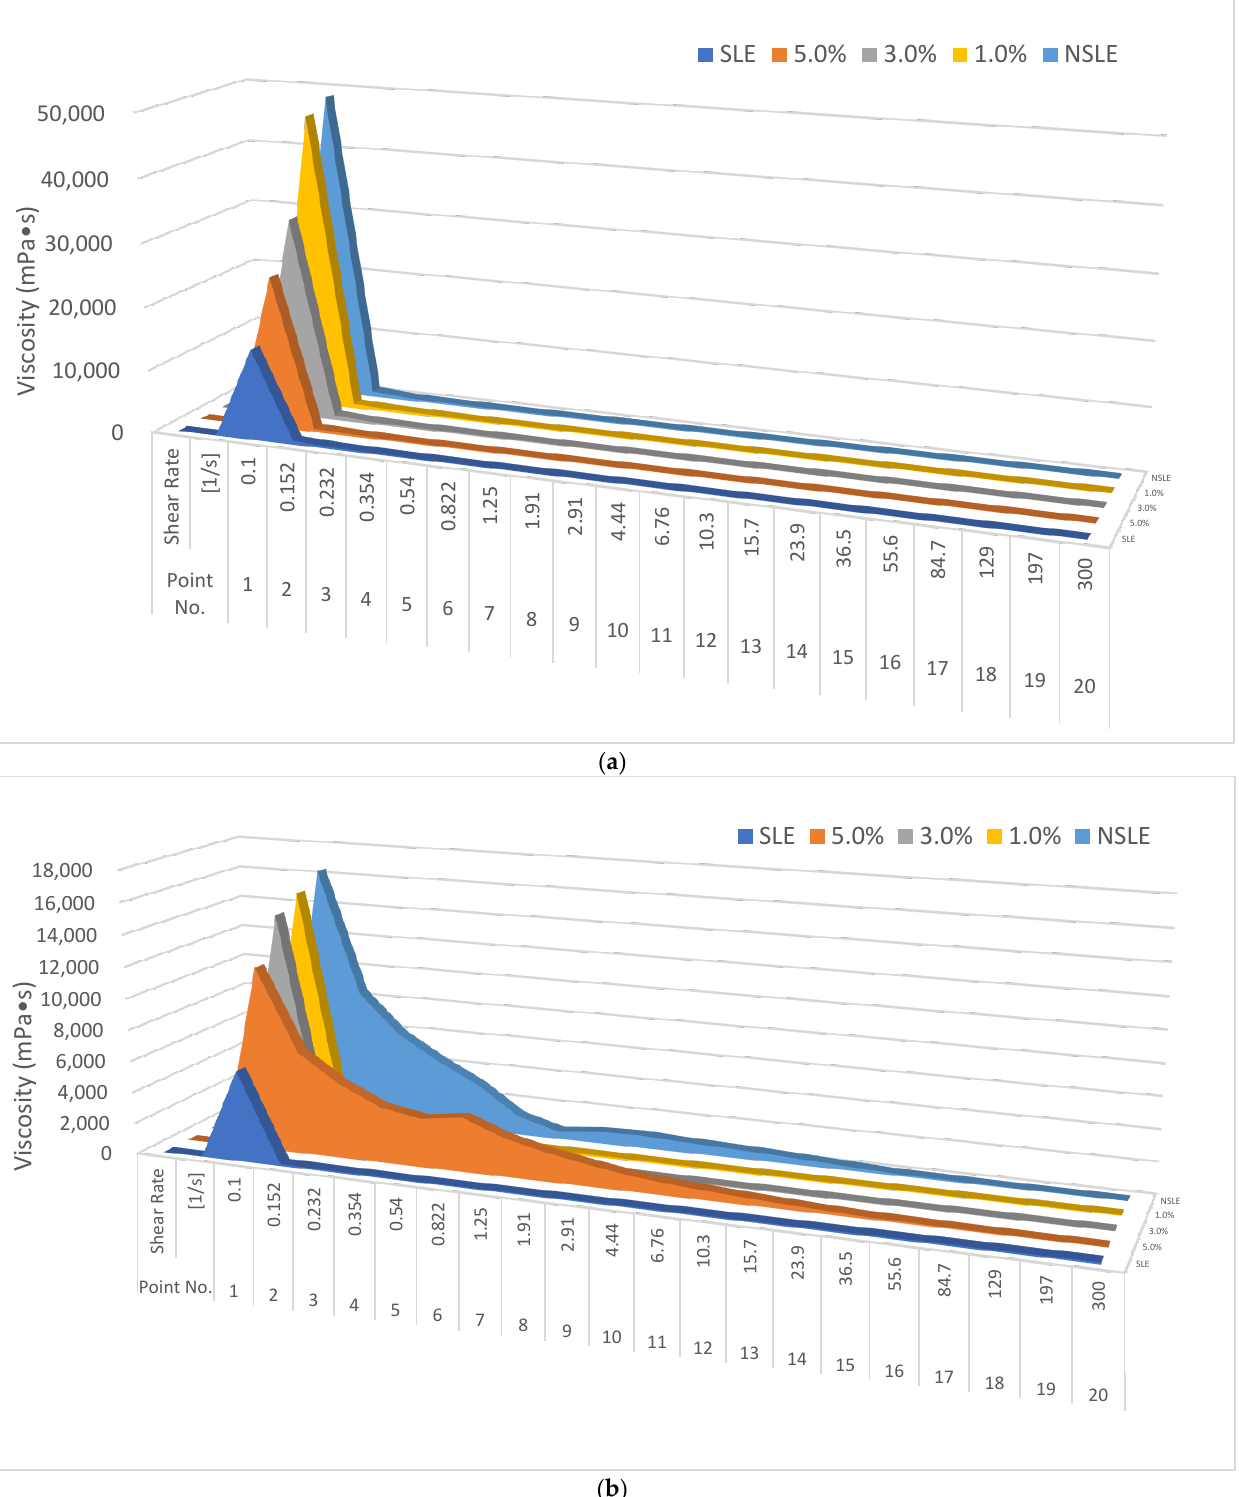
Figure 1. Viscosity of non-sterilized liquid egg white (NSLE), sterilized liquid egg white (SLE), and SLE supplemented with 1%, 3%, or 5% egg white hydrolysate (EWH) on Day 0 ( a ) and Day 7 ( b ).